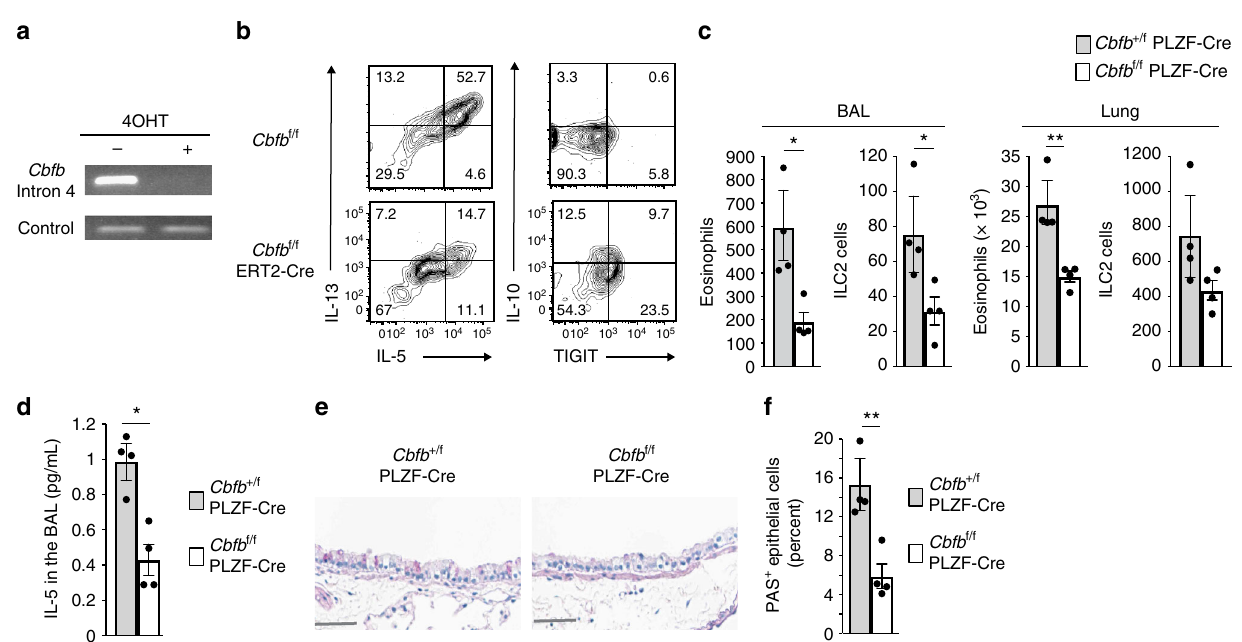
Fig. 9 Exhausted-like hyporesponsiveness of ILC2s attenuates allergic in fl ammation. a PCR analysis of the fl oxed intron 4 in the Cbfb gene compared to the un fl oxed genes (control) in Cbfb f/f ERT2-Cre ILC2s cultured with IL-2, IL-7, and IL-33 with or without 4-hydroxytamoxifen (4OHT). b Flow cytometry analysis of IL-5, IL-13, IL-10, and TIGIT expression by Cbfb f/f or Cbfb f/f ERT2-Cre ILC2s cultured with 4OHT. c – f Rag2 – / – Il2rg – / – mice were adoptively transferred with Cbfb f/f or Cbfb f/f ERT2-Cre ILC2s (1 × 10 6 cells/mouse) prepared as in b and administered papain intranasally on days 0, 1, and 2. On day 3, the absolute numbers of eosinophils and ILC2s in the bronchoalveolar lavage (BAL) fl uid and lung ( c ) and the IL-5 concentration in the BAL fl uid ( d ) from the recipient mice were analyzed by fl ow cytometry and ELISA, respectively. Histology ( e ) and the frequency ( f ) of PAS-positive lung epithelial cells in the indicated recipients. In c , d , f , * p < 0.05 and ** p < 0.01 by Student ’ s t -test. Data are representative of at least two independent experiments (mean ± s.d. of four mice in c , d , f